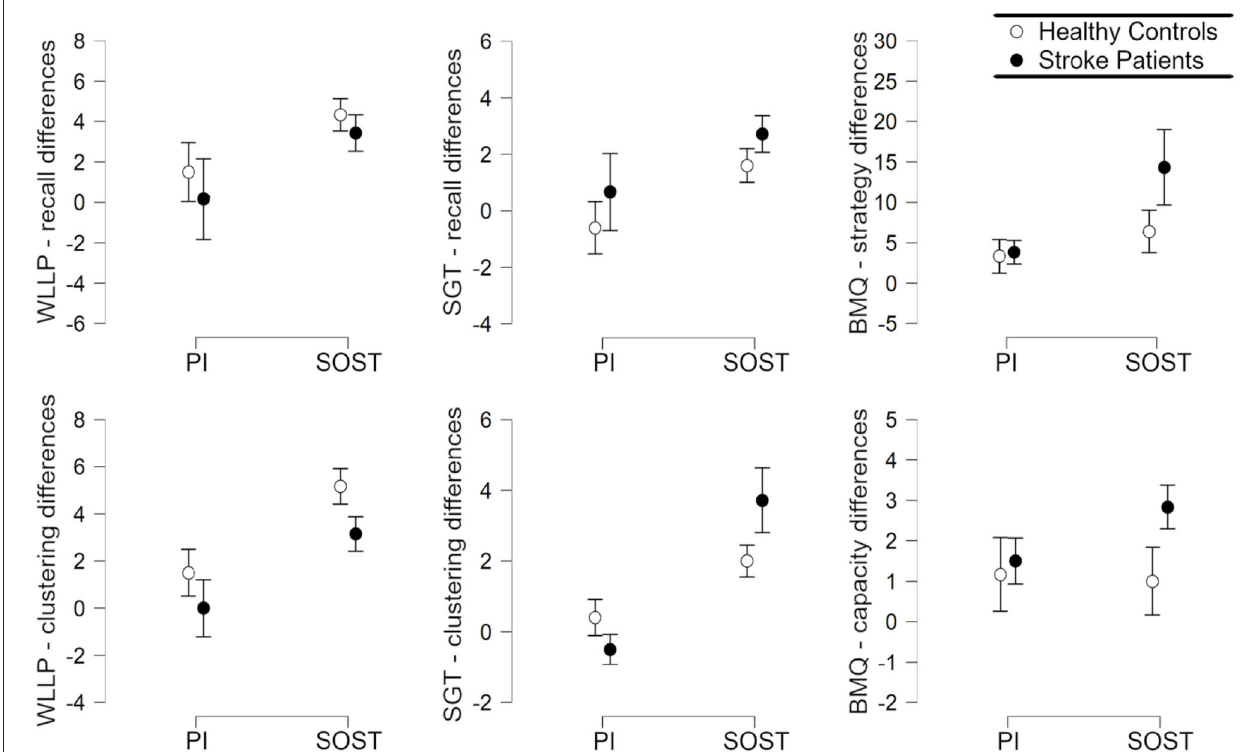
FIGURE 4 | Plots of the Post vs. pre intervention average differences, with standard error bars, according to group (Healthy Controls; Stroke patients) and intervention (SOST, Semantic Organization Strategy Training; PI, Psychoeducation Intervention), for each of the 6 dependent variables evaluated: Word-List Learning Paradigm (WLLP) recall; WLLP clustering score; Supermarket Generalization Task (SGT) recall; SGT clustering score; brief metamemory questionnaire (BMQ) strategy use; and BMQ capacity.